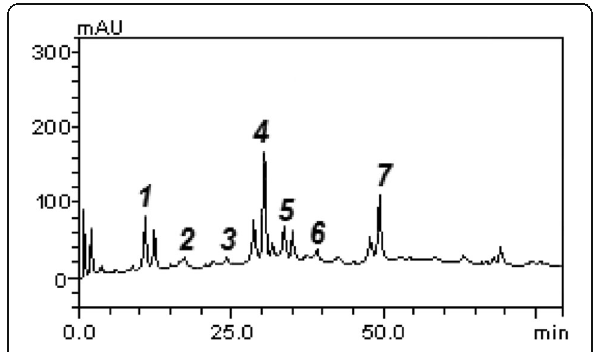
Fig. 1 Representative high performance liquid chromatography profile of Terminalia chebula fruit . Gallic acid (peak 1), catechin (peak 2), caffeic acid (peak 3), ellagic acid (peak 4), epicatechin (peak 5), rutin (peak 6) and quercetin (peak